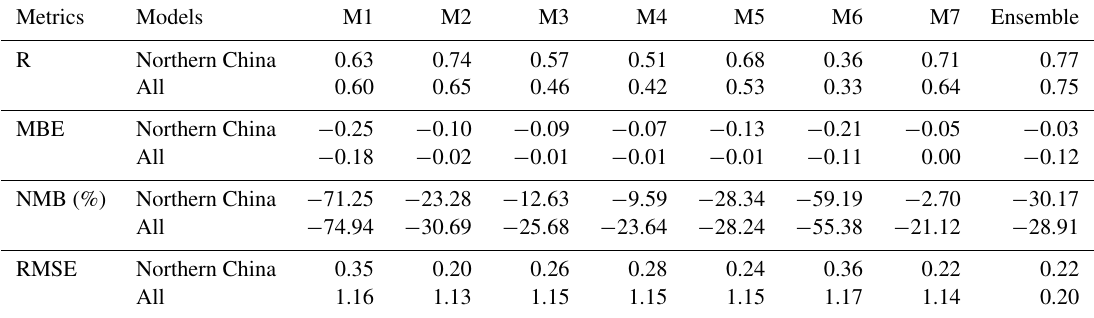
Table 6. Performance statistics of